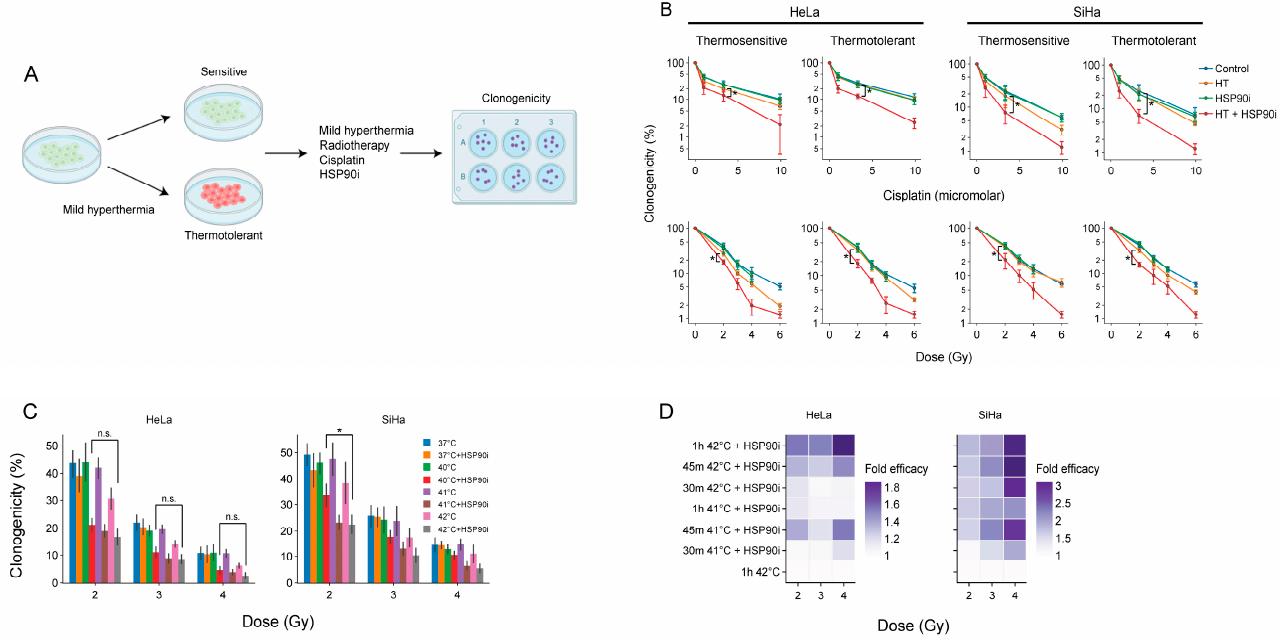
Figure 3. Ganetespib re-sensitizes thermotolerant cells and promotes the effects of hyperthermia- based treatments at lower thermal doses. ( A ) Experimental setup. Cervix cancer cells were rendered thermotolerant by hyperthermia (HT) treatment 24 h before exposure to 2 Gy of radiotherapy or 3.3 µ M of cisplatin in the absence or presence of 30 nM of ganetespib (HSP90i). Clonogenicity was used as a readout for therapy efficacy. ( B ) Clonogenicity of control and thermotolerant cells after exposure to various chemo- and radio-thermotherapy regimens. Noteworthy significant differences are marked with an asterisk. Not significant: “n.s.”. ( C ) Clonogenicity after treatment with radio- thermotherapy at lower thermal doses, in the presence or absence of ganetespib. ( D ) Enhancement ratio of chemo- and radio-thermotherapy outcomes at lowered thermal dose in the presence of ganetespib, displayed as a fold-increase relative to the respective treatment without ganetespib. The horizontal dotted line marks no enhancement.